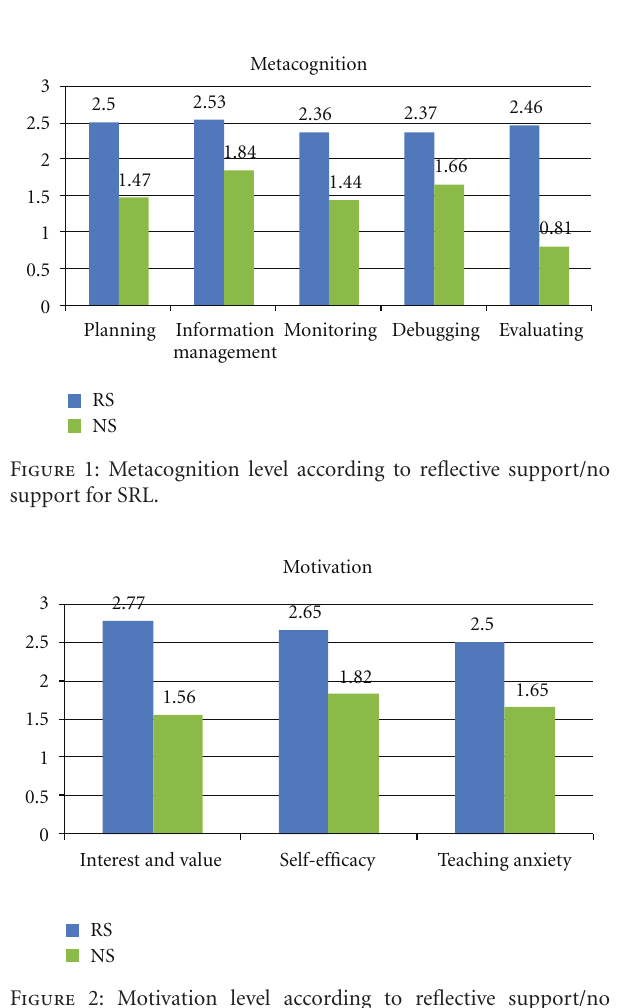
Figure 2: Motivation level according to reflective support/no support for SRL.